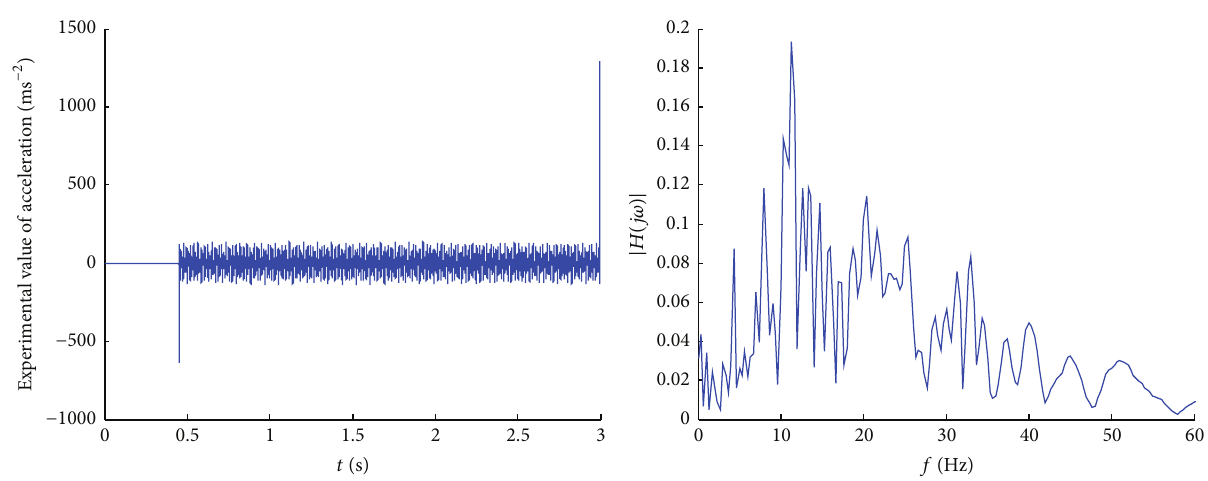
Figure 13: The acceleration value and the frequency response function 𝐻(𝑗𝜔) of the first experimental process.